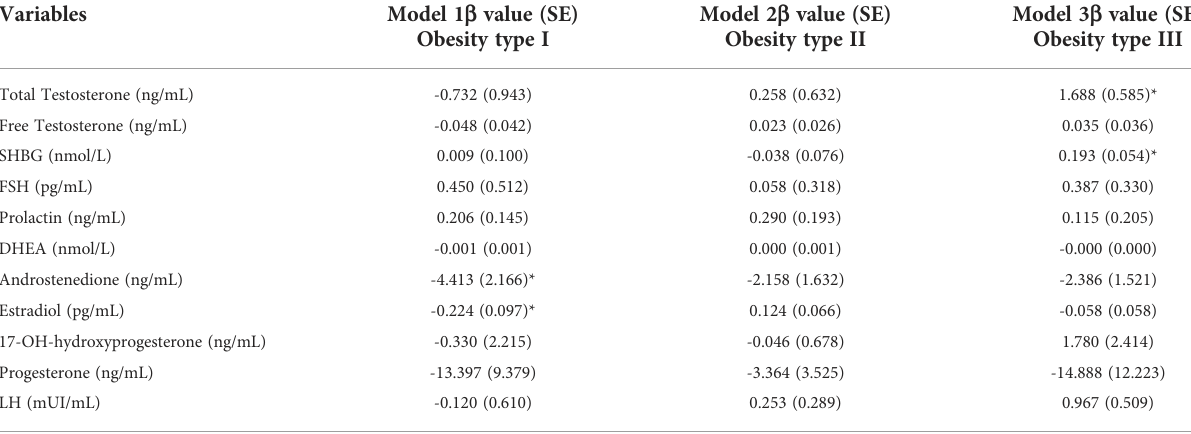
TABLE 4 Linear regression model assessing the association between 25-hydroxyvitamin D with sex-related hormones, analyzing different grades of